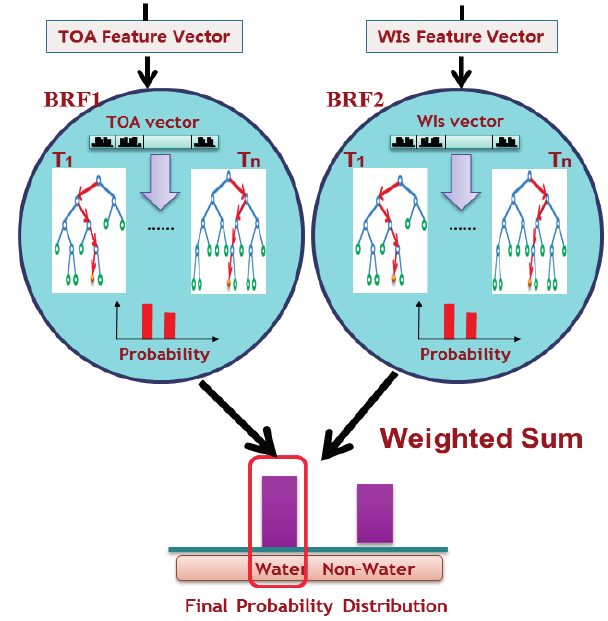
Figure 2. Water body classification process using the combination of two trained BRFs. The test pixel of input image is placed into the class that has the maximum posterior probability. After every pixel is classified either as a water body or background, neighboring water body pixels are merged into water regions using morphological closing. If the number of pixels of a water region is below 30 pixels after merging, it is declared as noise and removed. Proposed system is implemented using the same environment of Visual C++ language an Intel Quad-Core i7 processor PC running Windows 7